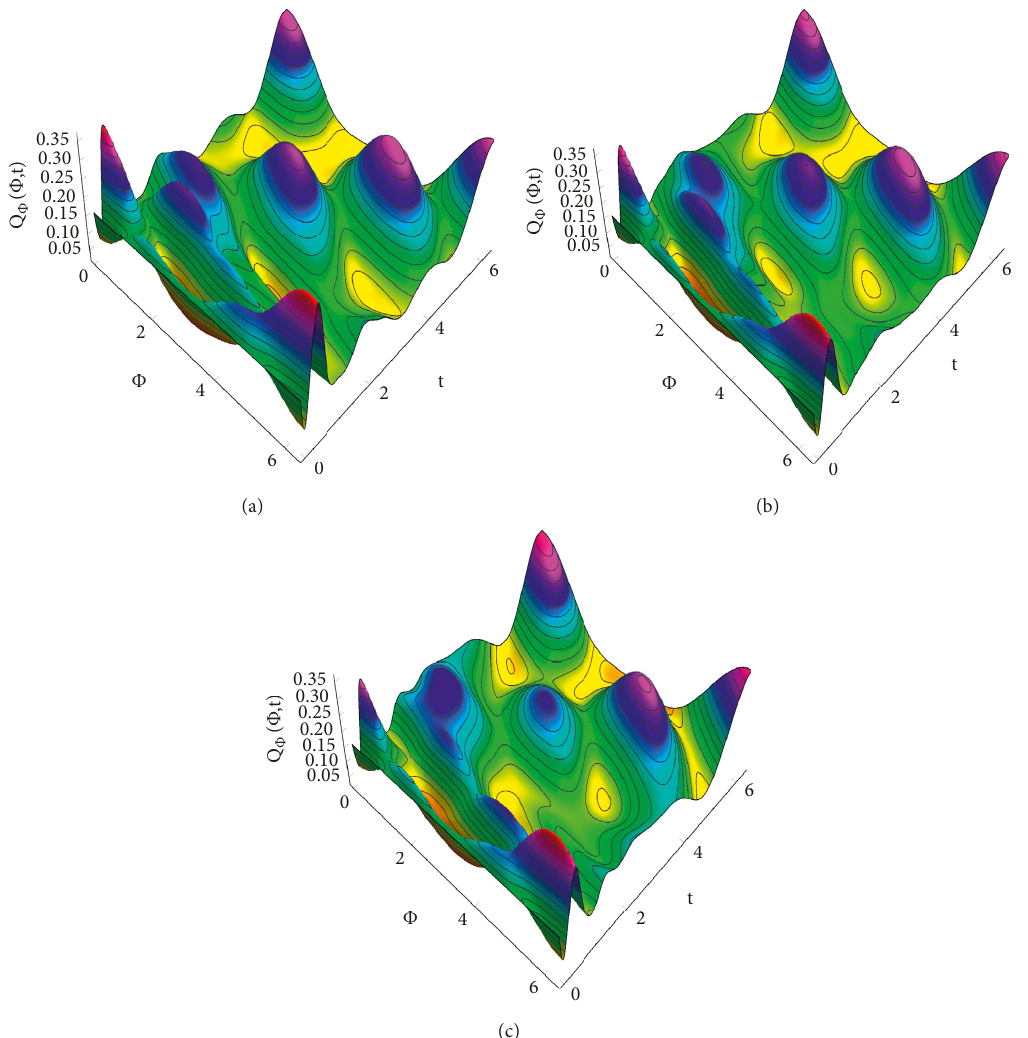
( t ) as a function of the scaled time t with, ϖ � 0 . 2 , q � 3 , ξ � 16, Δ ϕ